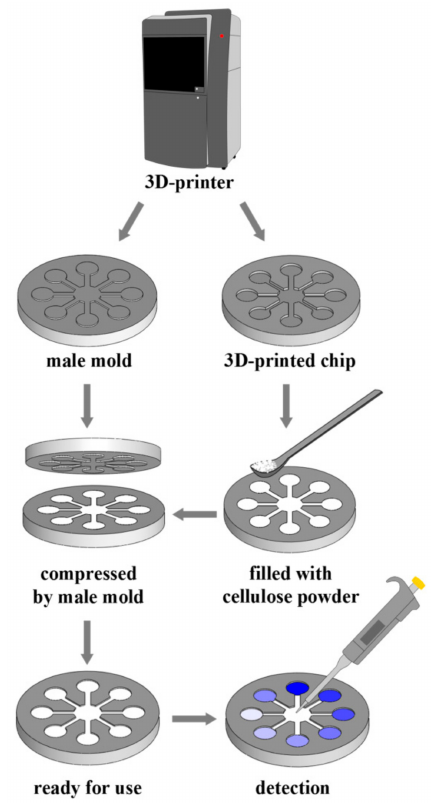
Figure 1. The fabrication process of the